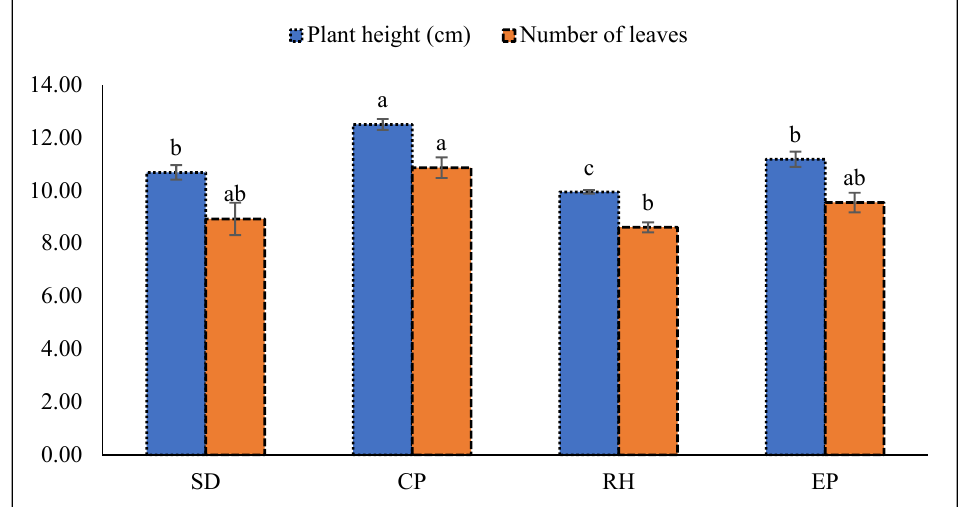
Figure 3. Plant height and leaf number are influenced by different growing media. Abbreviations are as follows for substrate mixtures of cocopeat: sawdust: rice husk in the following proportions: 1:3:1 (SD sawdust); 3:1:1 (CP cocopeat); 1:1:3 (RH rice husk); and 1:1:1 (EP equal proportions of all three organic substrates). Different letters in the same column indicate significant differences between treatments ( p < 0.05). Vertical bars indicate standard errors of means.